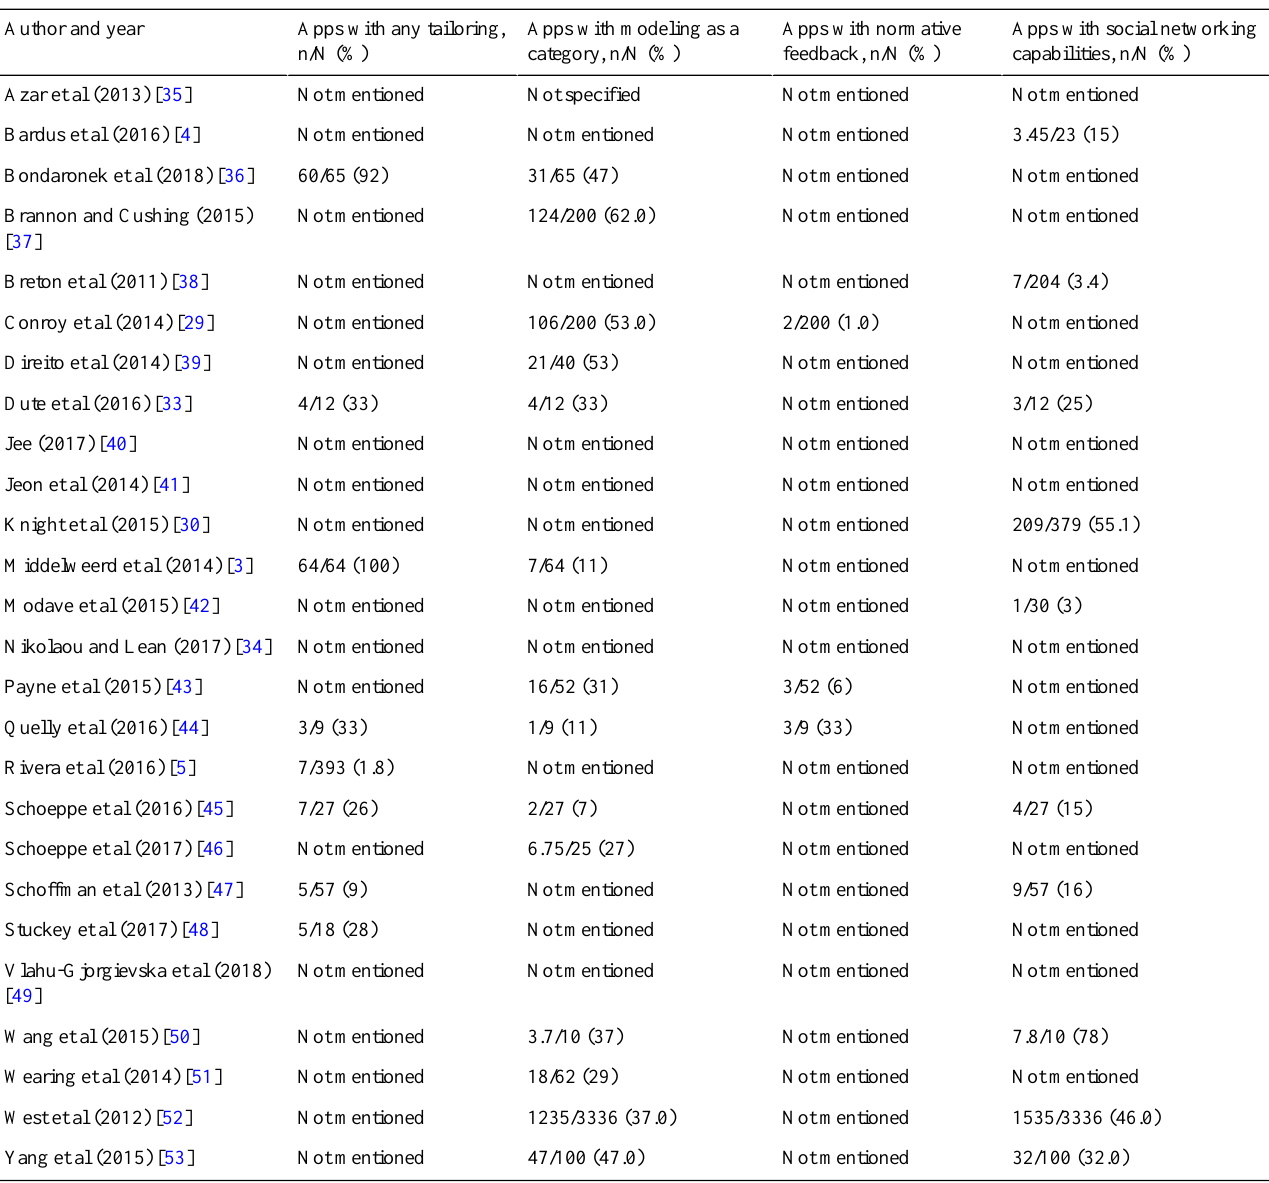
Table 5. Summary of tailoring, modeling, norm referencing, and social networking data extracted from each review of physical activity apps.